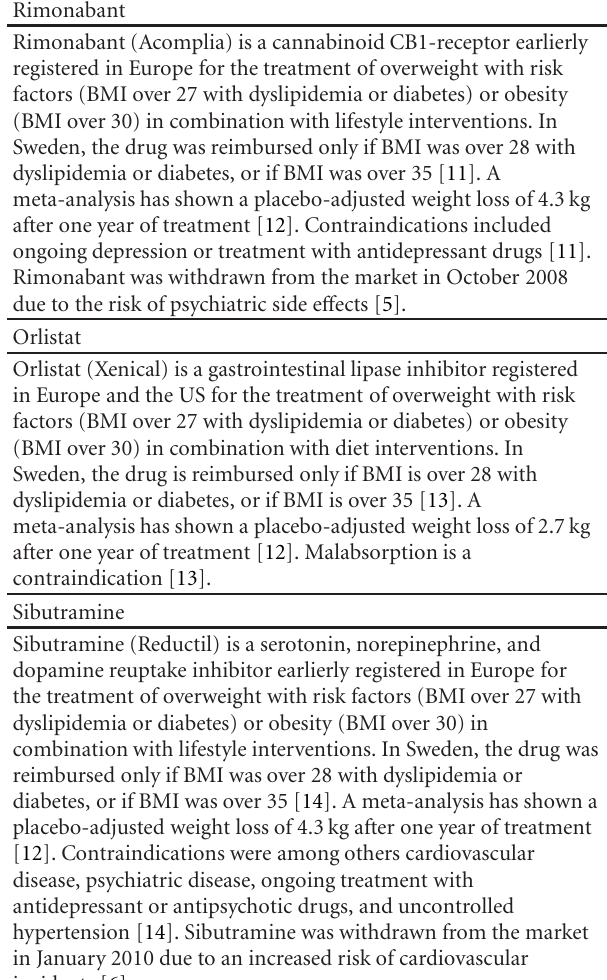
Table 1: The three weight-loss drugs on the Swedish market in 2008.